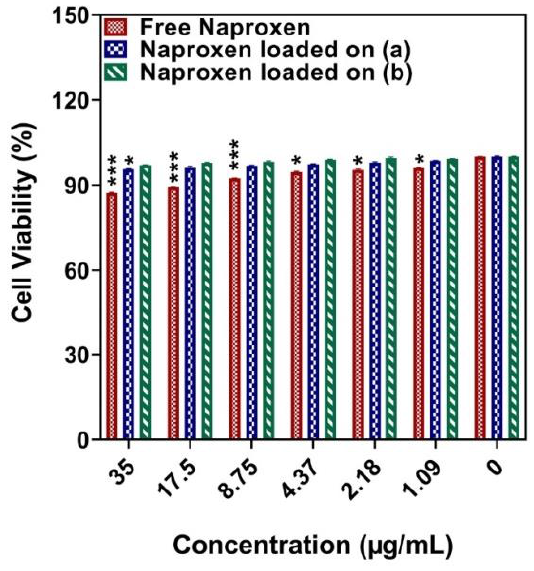
Figure 9. The effect of free drug and drug-loaded carriers (a) Ni 1−x Co x Fe 2 O 4 @Methionine NPs and (b) Ni 1−x Co x Fe 2 O 4 @Methionine@PEG NPs on the viability of normal MCF10A cells after incubation for 72 h. Data are expressed as mean ± SD ( n = 5) (*** p < 0.001, ** p < 0.01, * p < 0.05). Table 2. IC 50 values of naproxen and naproxen-loaded carriers on MCF-7 and MDA-MB-231 cells.